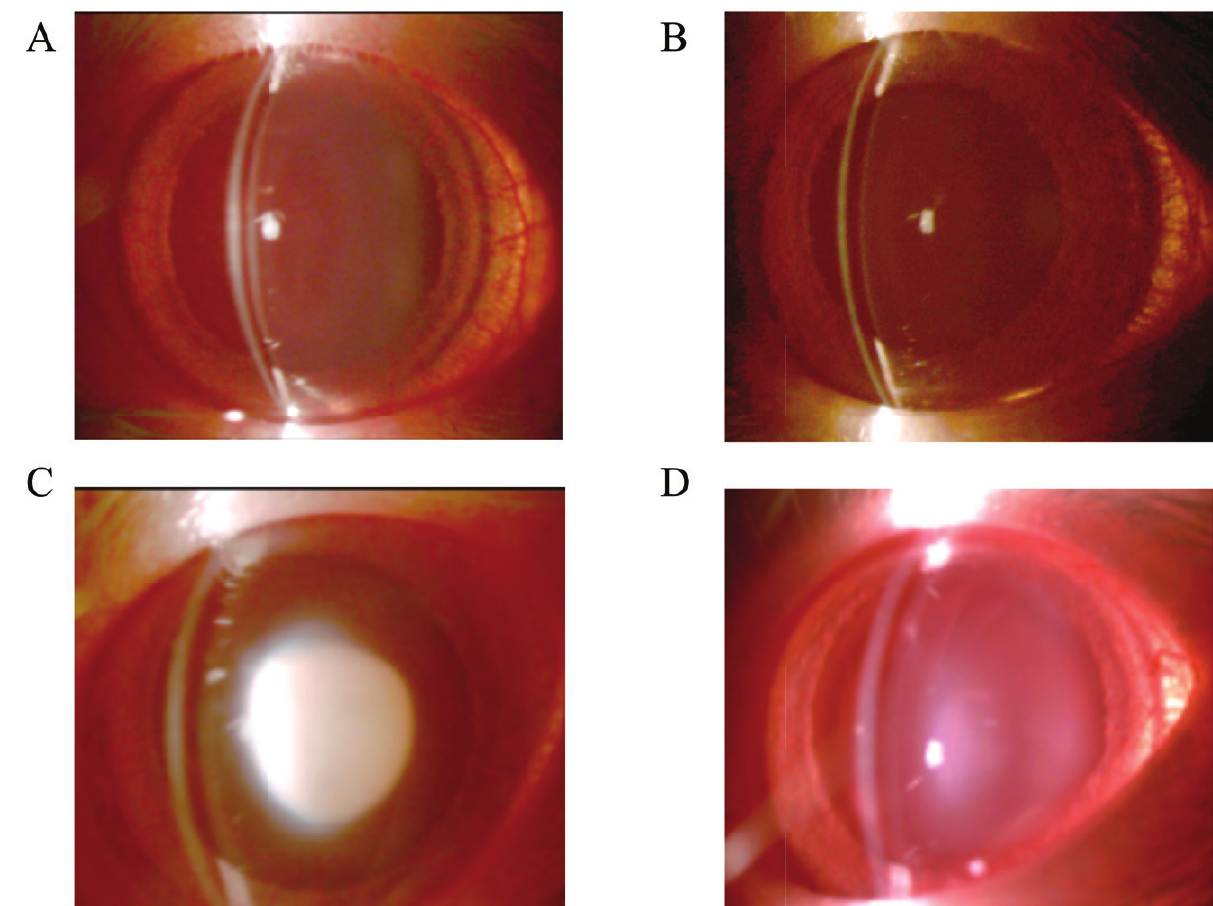
Figure 1:. Effect of hespertin for cataractgenesis induced selenite administration. Groups G1 and G2 were injected with vehicle (control) and groups G3 and G4 were injected with sodium selenite subcutaneously into 13-day-old rats (Day 0). Hesperetein was administered to groups G2 and G4 subcutaneously in 13-, 14-, and 15-day-old rats (Day 0, 1, and 2, respectively). All lenses are taken 6 days after selenite or vehicle administration. (A) G1: no selenite and no hesperetin treatment. (B) G2: no selenite and hesperetin treatment. (C) G3: selenite treatment and no hesperetin treatment. (D) G4: selenite and hesperetin treatment. Rats in groups G1 and G2 had transparent lenses. Rats in the G3